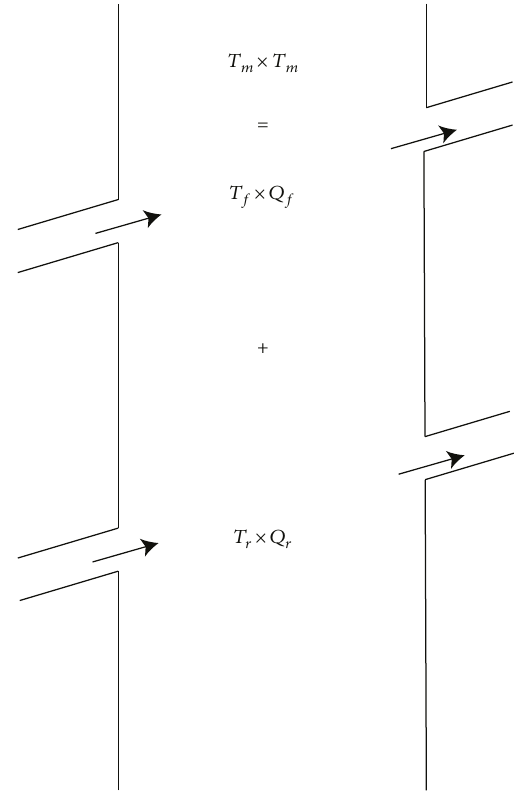
Figure 5: Scheme of the mixture of fl uids coming from fractures into a permeable